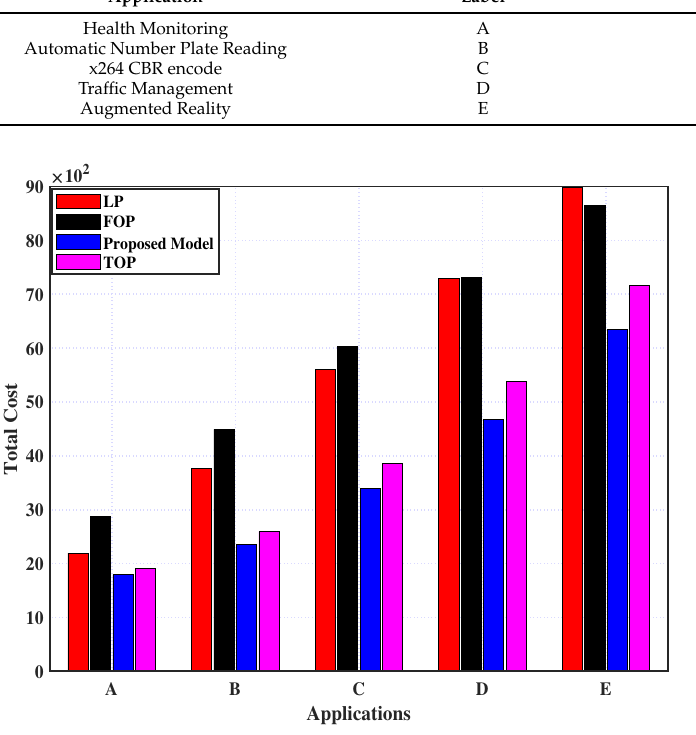
Figure 10. A comparison of total cost for different numbers of GBSs (K = 5, N = 3, K =